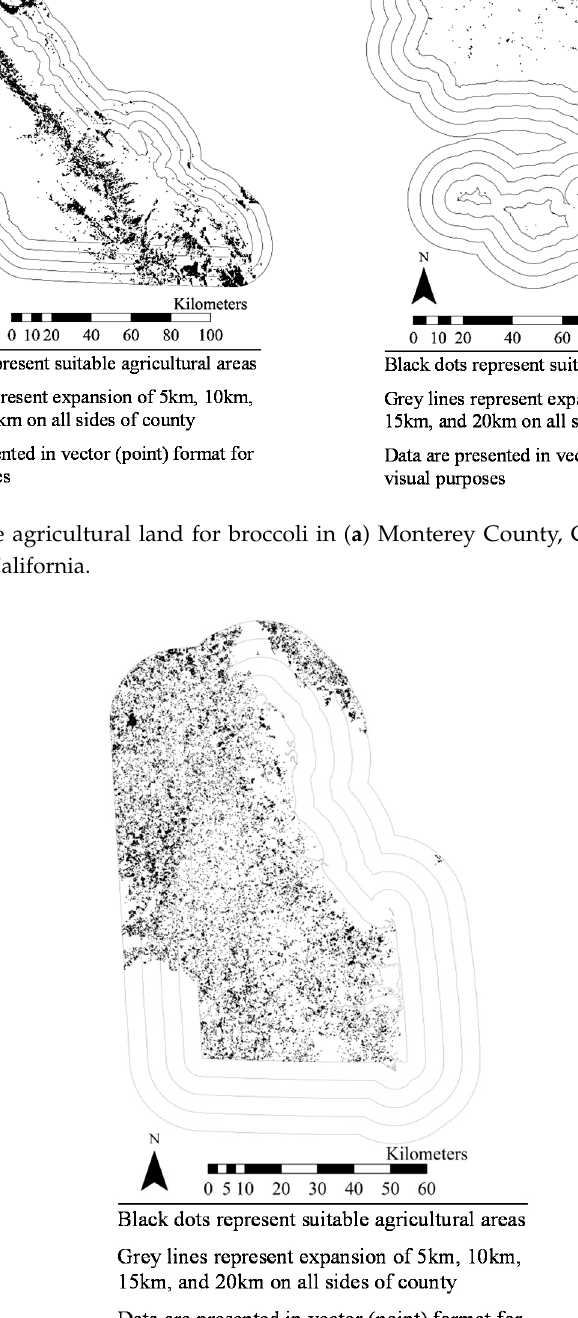
Figure 4. Suitable agricultural land for lima beans in Sussex and Kent Counties, Delaware.